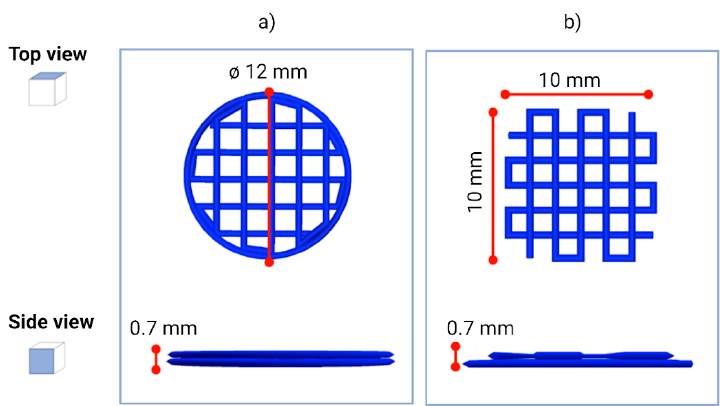
Figure 8. Design of the different 3D geometries used in the study. Schematic representation of the ( a ) cylindrical- and ( b ) square-structure CAD design.